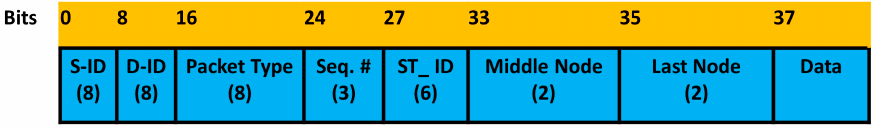
Figure 12. Packet Header Format.